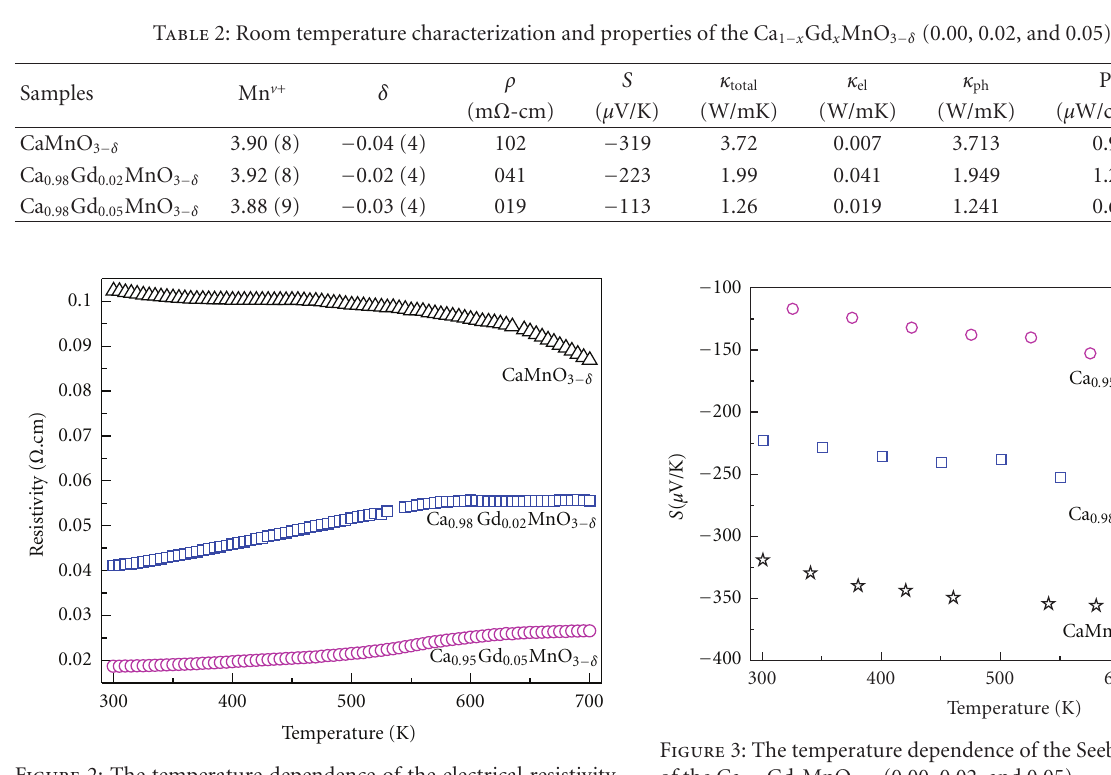
carriers due to oxygen defects. Since the increase of electrical conductivity ( ∼ e − E a /k B T ) is faster than the decrease of S ( ∼ E a /k B T ) for semiconductors, one could expect that the second term in (2) would increase and therefore the absolute value of thermopower for CaMnO 3 − δ would increase,